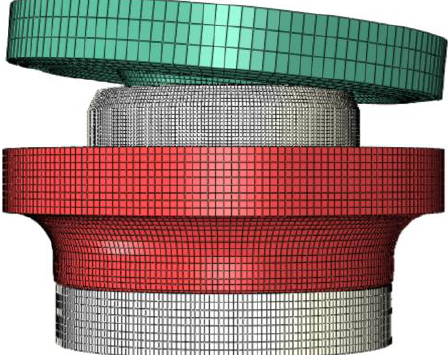
Figure 5. Finite element model of hub bearing assembly.